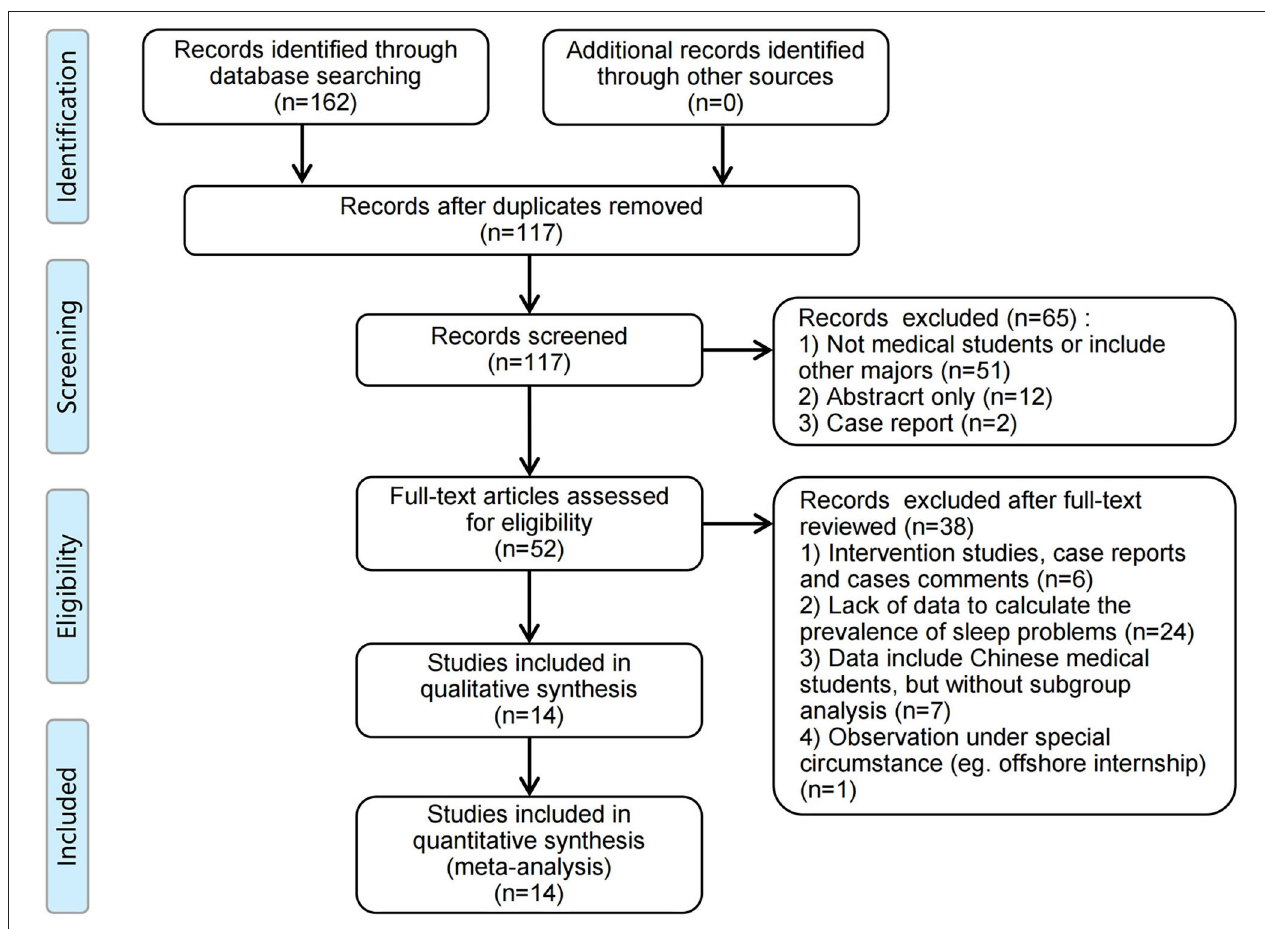
FIGURE 1 | PRISMA flow chart for the article filtering